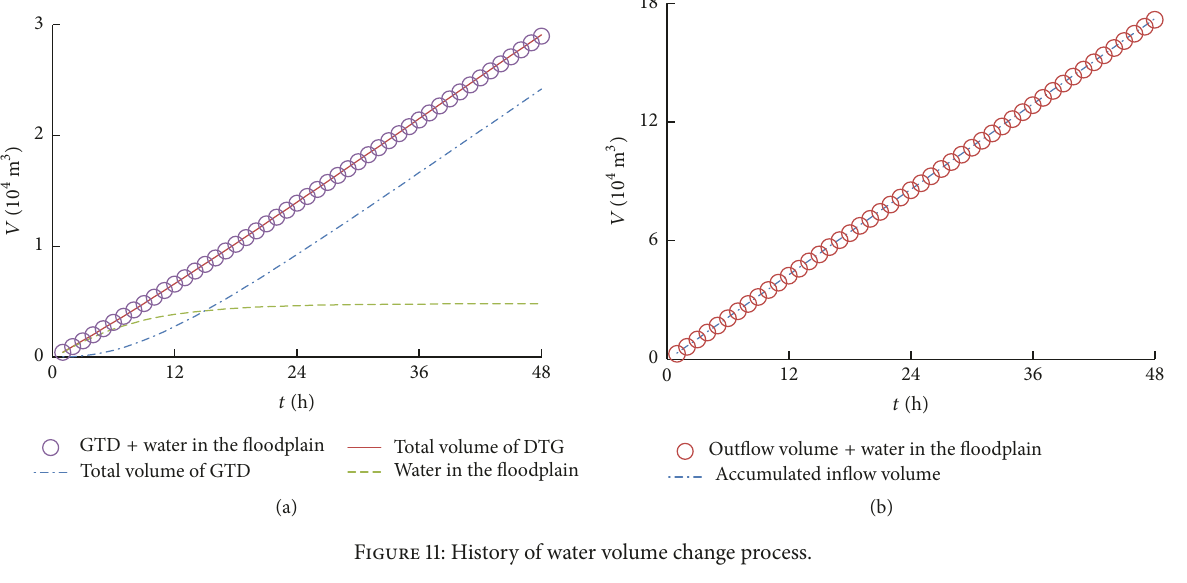
Figure 11: History of water volume change process.